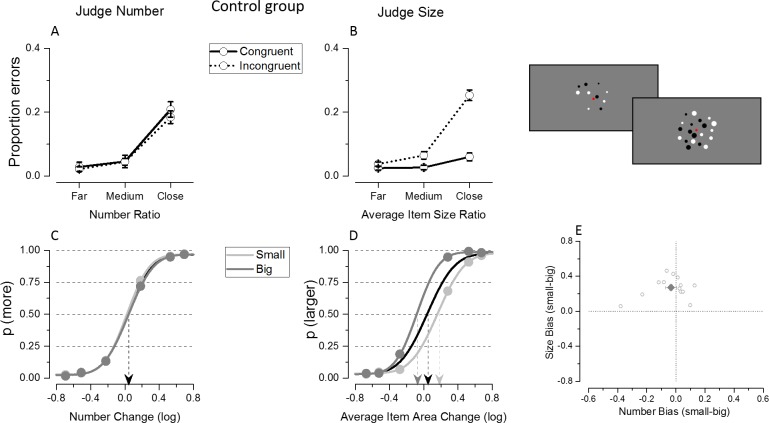
Results from Experiment 1 where control subjects were tested with sequentially presented stimuli.(A-B) Proportion of errors as a function of ratio of the attended dimension during numerical (A) and average size (B) judgments. Different lines show the error rate when participants were tested with congruent (solid line) or incongruent (dotted line) trials. (C-D) Psychometric functions for the control group for the number (C) and average size (D) tasks. Black curves fit the entire dataset while light and dark gray curves fit trials that are the small and the big, respectively, within the unattended dimension. Data in E show the average (dark big diamond) and single subjects’ PSE difference (light gray small circles) during numerosity (on the x axis) and average size (on the y axis) comparison when the dataset was split for the magnitude of the unattended dimension (small-big).